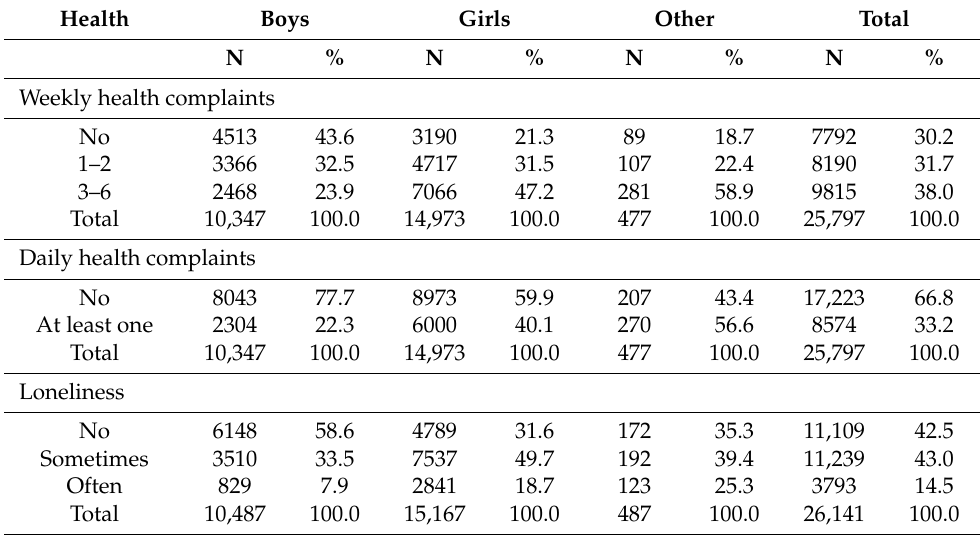
Table 1. Distributions of the health variables by